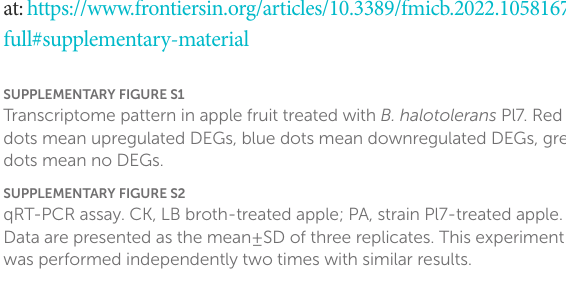
SUPPLEMENTARY FIGURE S1 Transcriptome pattern in apple fruit treated with B. halotolerans Pl7. Red dots mean upregulated DEGs, blue dots mean downregulated DEGs, grey dots mean no DEGs. SUPPLEMENTARY FIGURE S2 qRT-PCR assay. CK, LB broth-treated apple; PA, strain Pl7-treated